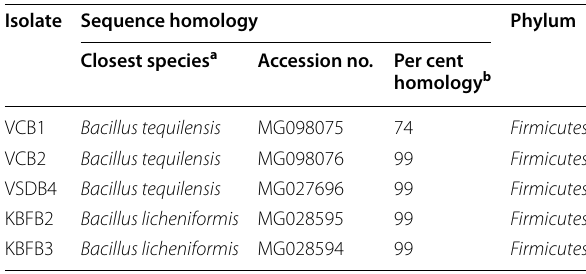
Table 3 Identification of thermophilic bacterial isolates by 16S rRNA gene sequence